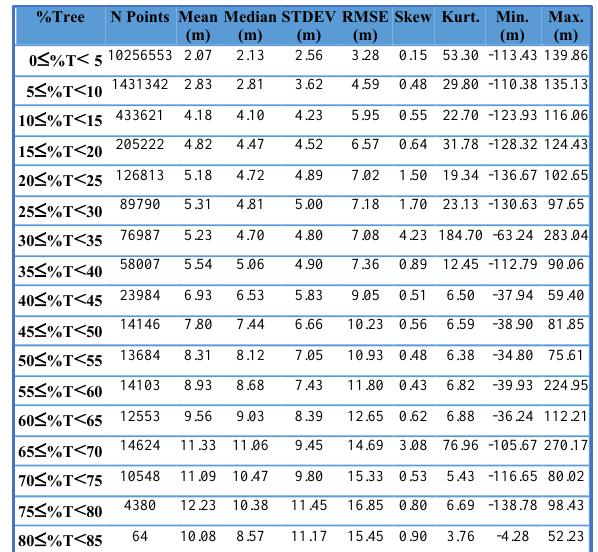
show on the top of Figure 3, mostly in the central part of the coastal regions of the South West and South East of the continent. cover decreases. Those data represent terrain elevations the canopy after classification is performed. Means and standard deviations for those categories increase with increased percent tree